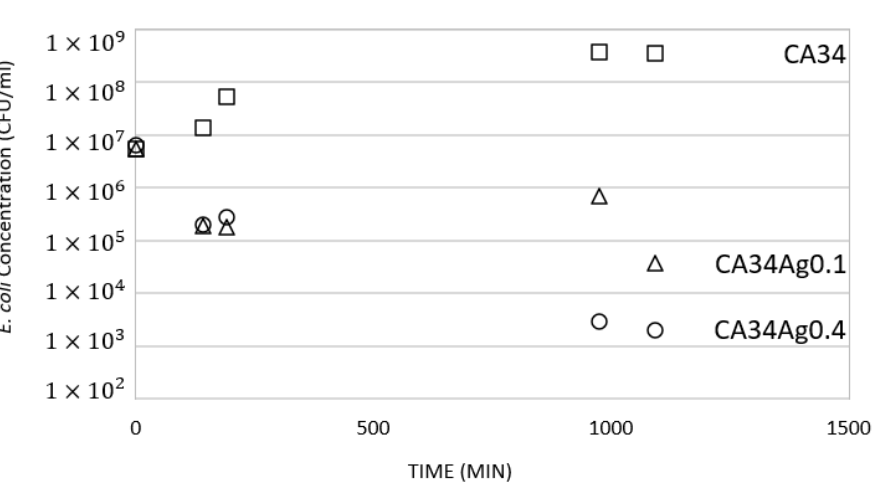
Figure 15. Variation of E. coli concentration (CFU/mL) at different contact times (143 min, 190 min, 975 min and 1093 min) of the suspensions with the membranes (□ , CA34; △ , CA34Ag0.1; and ⚬ , CA34Ag0.4).